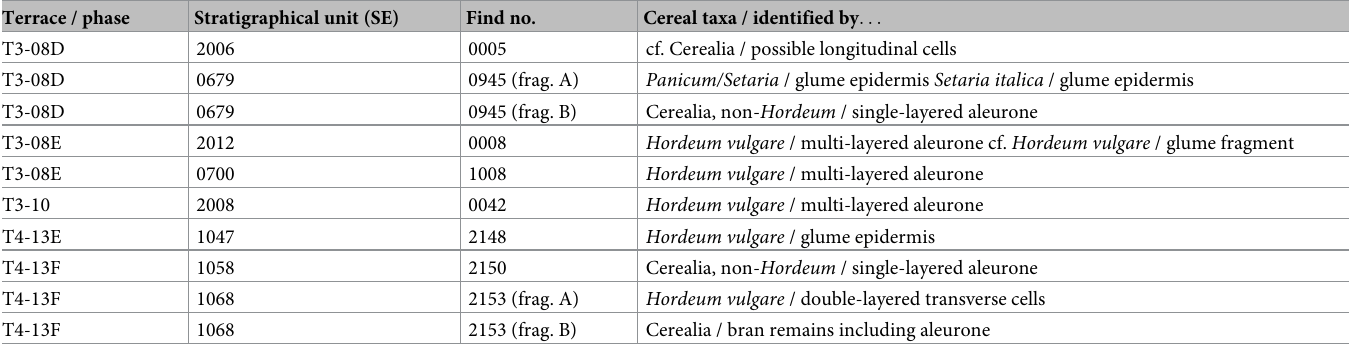
Table 2. Cereal components identified in the ACOs analysed via SEM. Terrace / phase Stratigraphical unit